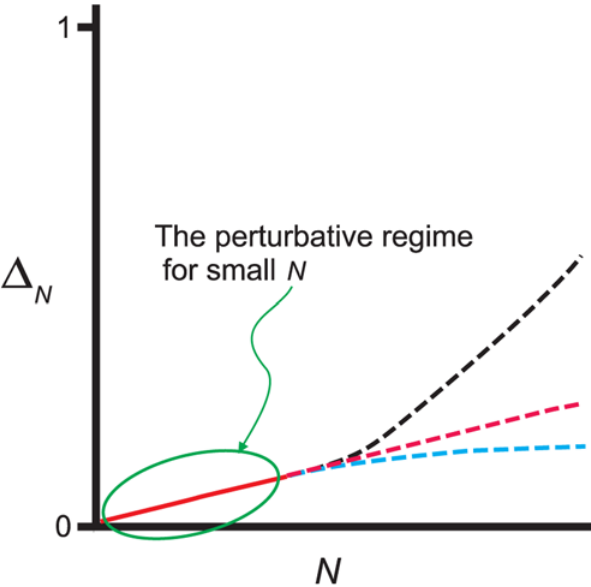
Figure 2. Cartoon illustrating the dependence of D N on N . For small N there is always a perturbative regime in which D N increases linearly with N (solid red line). When N becomes large, D N may continue increasing with N (red and black dashed lines) or it may plateau (cyan dashed line), depending on p true . The observation that D N increases linearly with N does not, therefore, provide much, if any information about the large N behavior.